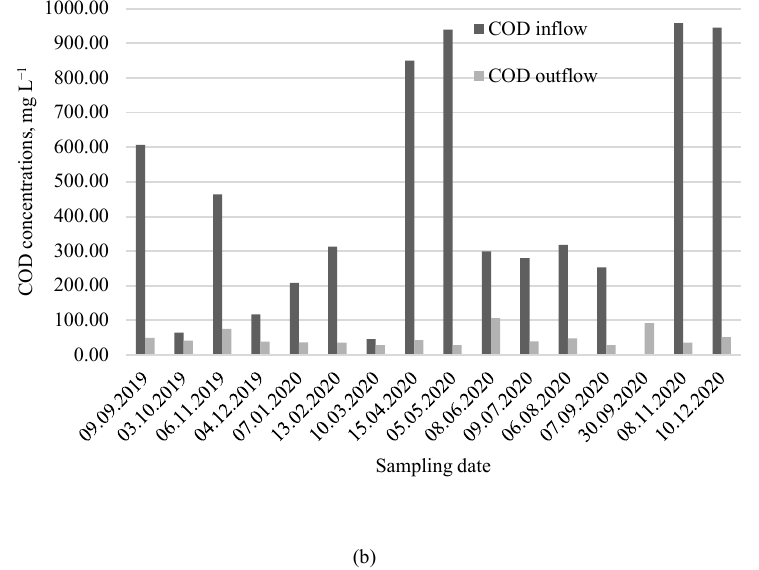
Fig. 6. The concentrations (mg L –1 ) of a) BOD 5 and b) COD at the inflow and outflow of the storm water treatment system with subsurface flow constructed wetland. The concentrations by the sampling date at the inflow and outflow is demonstrated at Fig.